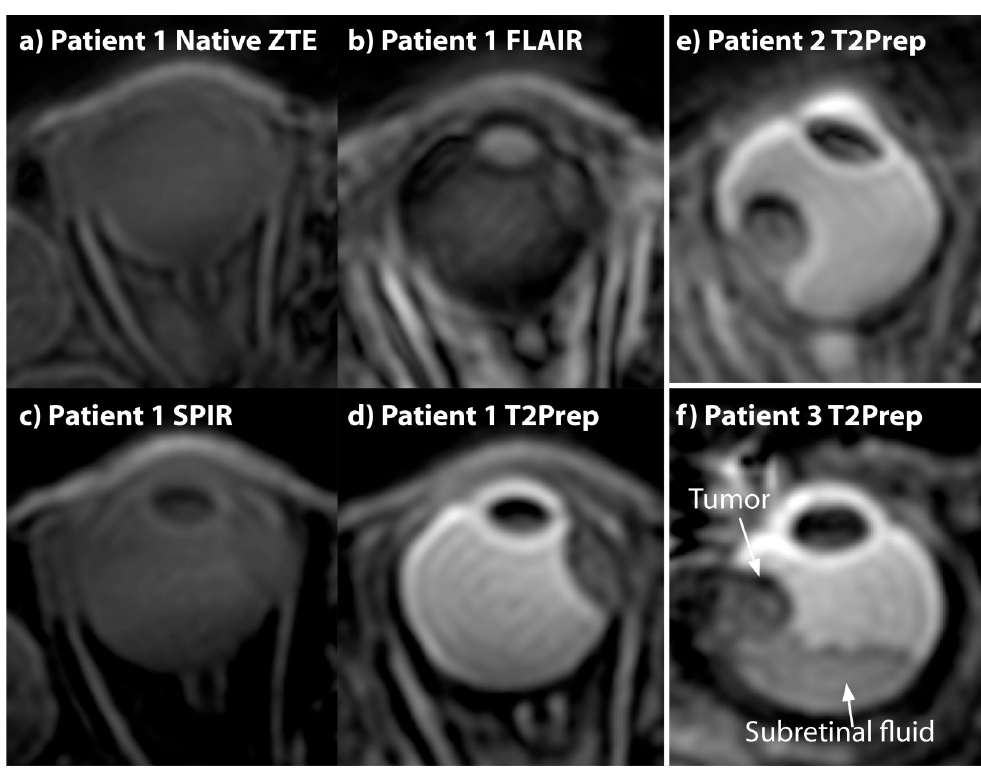
Fig 4. Magnetization-prepared ZTE imaging of the eye of three uveal melanoma patients. (a-d) ZTE images showing different magnetization preparation of one of the patients (isotropic (1mm 3 ) resolution). In the native and fat suppressed ZTE the tumor cannot be discriminated from the surrounding tissues. The FLAIR ZTE does result in some degree of contrast between the vitreous body, but the tumor boundaries are not clearly identifiable as not all the signal from the vitreous body is suppressed. The T 2 -prepared ZTE, however, does provide a good contrast in which the tumor boundaries are clearly visible. (e,f) T 2 -prepared ZTE scans of two other patients, showing clearly the tumor in the eye. The third patient (f) furthermore suffers from a retinal detachment, a common complication of an ocular tumor, which results in fluid accumulation behind the retina. This subretinal fluid can be identified as a region which has a signal intensity between the tumor and the vitreous